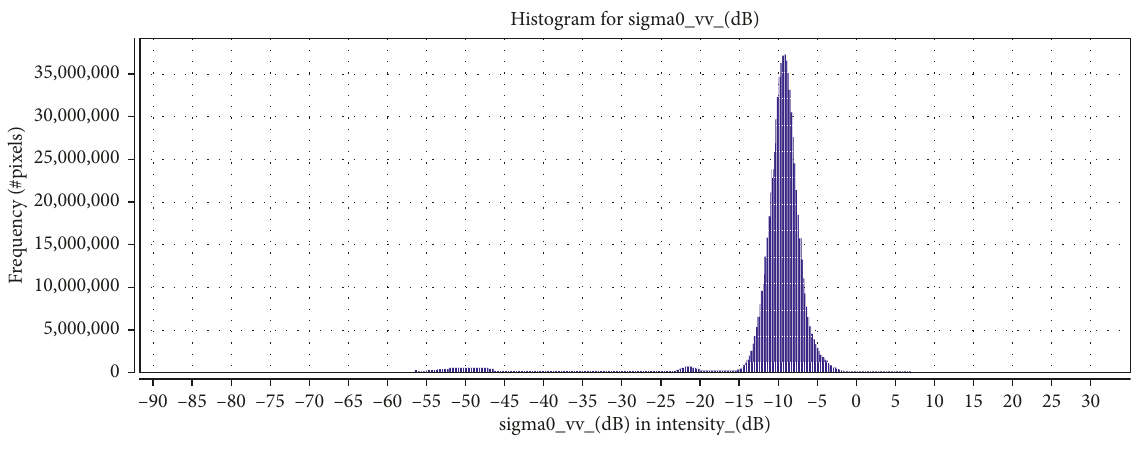
Figure 12: Computing histogram (source: